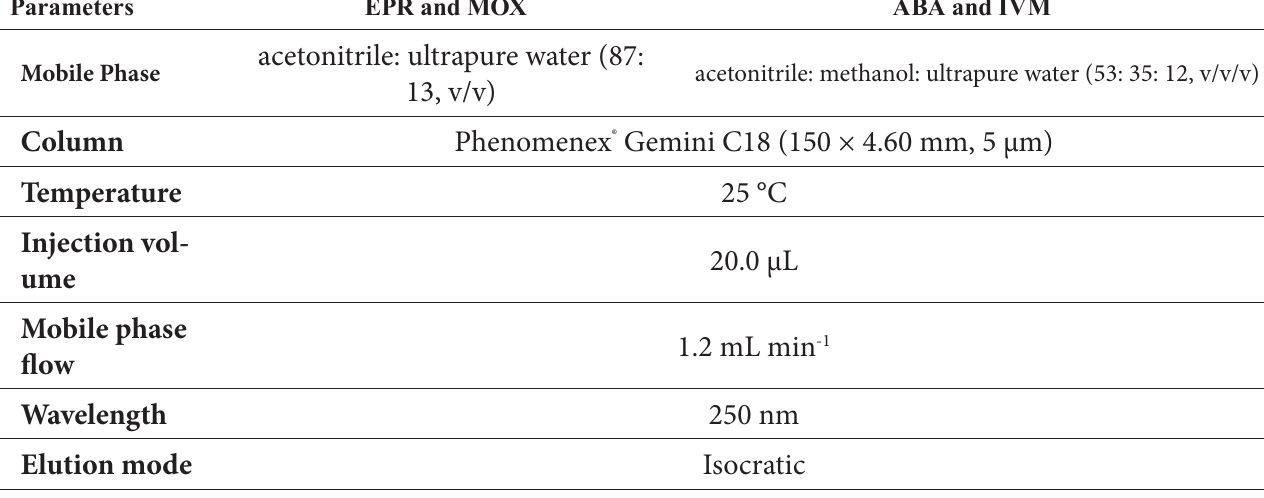
TABLE II - Optimized conditions for simultaneous analysis of drugs Parameters EPR and MOX ABA and IVM Mobile